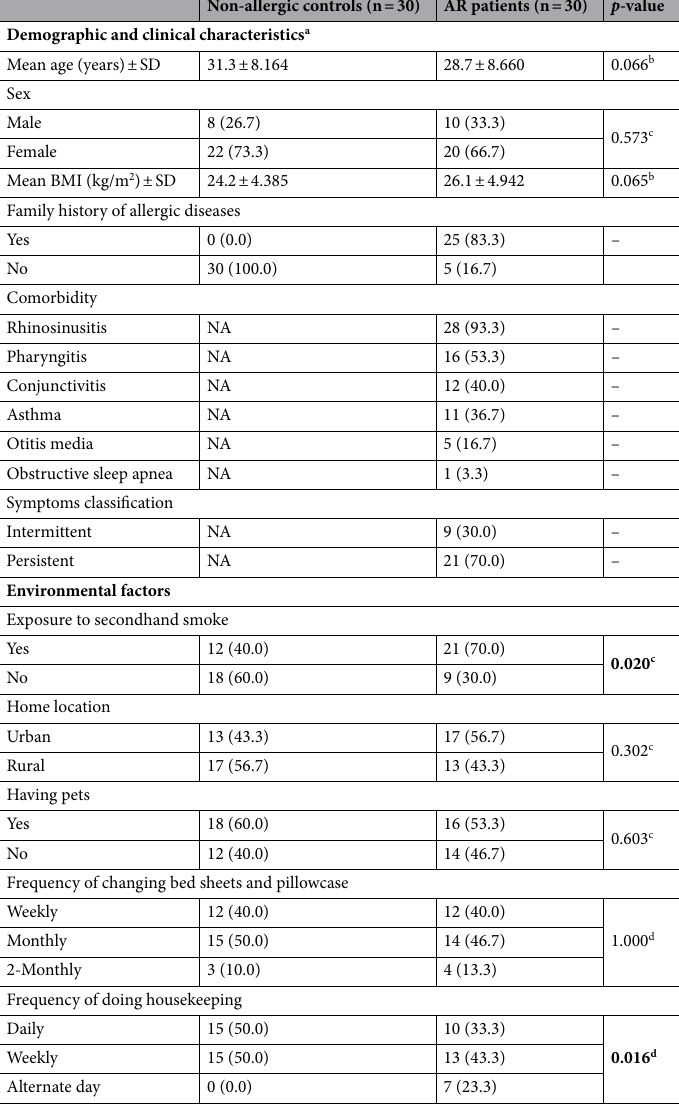
Table 1. Demographic, clinical characteristics and environmental factors of non-allergic controls and AR patients. Abbreviations: AR, allergic rhinitis; BMI, body mass index; SD, standard deviation; NA, not applicable. a Data are presented as number (percentage) unless stated otherwise. b Mann–Whitney test. c Chi- square test. d Fisher’s exact